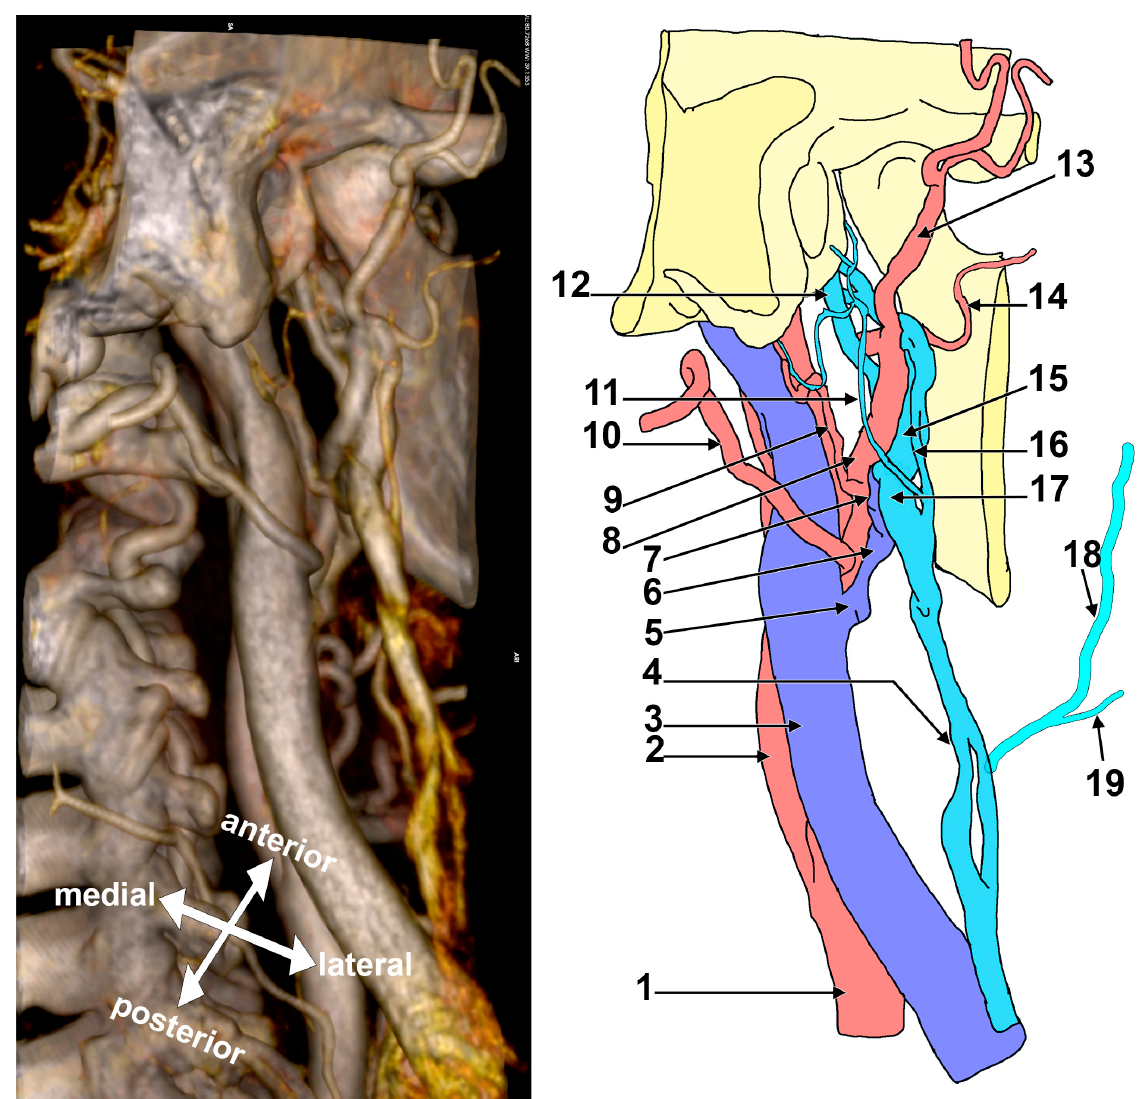
Figure 1. Right postero-infero-lateral view of the retromandibular fossa. Three-dimensional volume rendering and drawing (the branches of the external carotid artery in the carotid triangle were omitted). 1. Common carotid artery; 2. internal carotid artery; 3. internal jugular vein; 4. fenestrated external jugular vein; 5. thyro-linguo-facial trunk; 6. external carotid vein (Launay’s vein); 7. antero-medial branch of the retromandibular vein; 8. external carotid artery; 9. posterior auricular artery; 10.occipital artery; 11. posterior auricular vein; 12. posterior pharyngeal trunk; 13. superficial temporal artery; 14. transverse facial artery; 15. deep limb of the fenestrated retromandibular vein; 16. superficial limb of the fenestrated retromandibular vein; 17. postero-lateral branch of the retromandibular vein. Also included are the facial vein (18), which drains in the anterior arm of the fenestrated external jugular vein, and a submental tributary (19) of the facial vein.